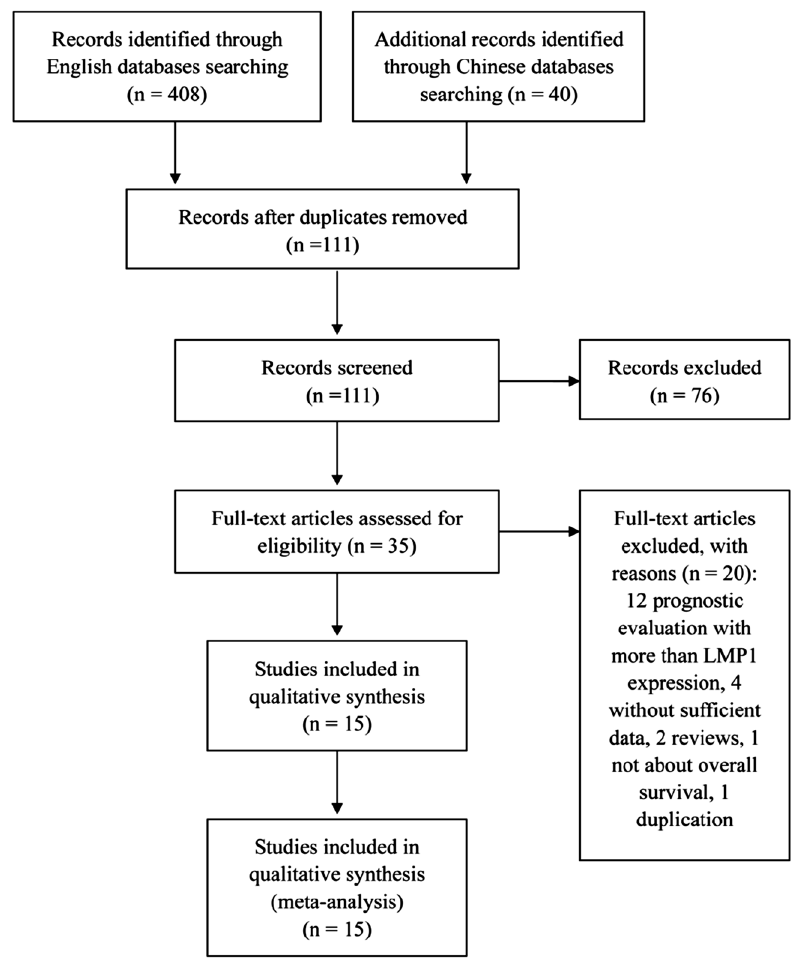
Figure 1. PRISMA flow diagram for selection of studies in the meta-analysis.